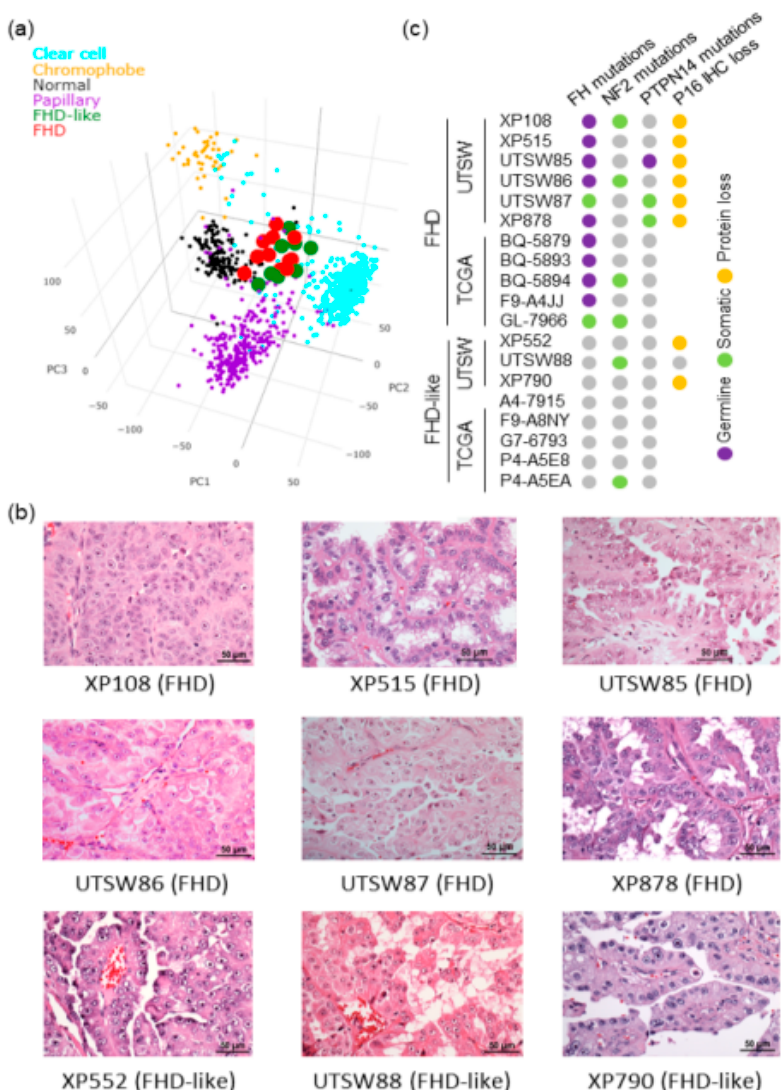
Figure 6. SCINA identified a novel RCC tumor clade based on gene expression profiling. ( a ) 3D Principal Component Analysis (PCA) plot showing clustering of UTSW KCP and TCGA RCC and normal kidney samples by expression (n = 1068). ( b ) H&E stained sections showing that both FH-deficient (FHD) and FHD-like tumors had features characteristic of hereditary leiomyomatosis and renal cell cancer (HLRCC), including papillary architecture, large nuclei, and prominent eosinophilic macronucleoli, with perinucleolar clearing. ( c ) Somatic/germline mutations and IHC results for FHD and FHD-like tumors.